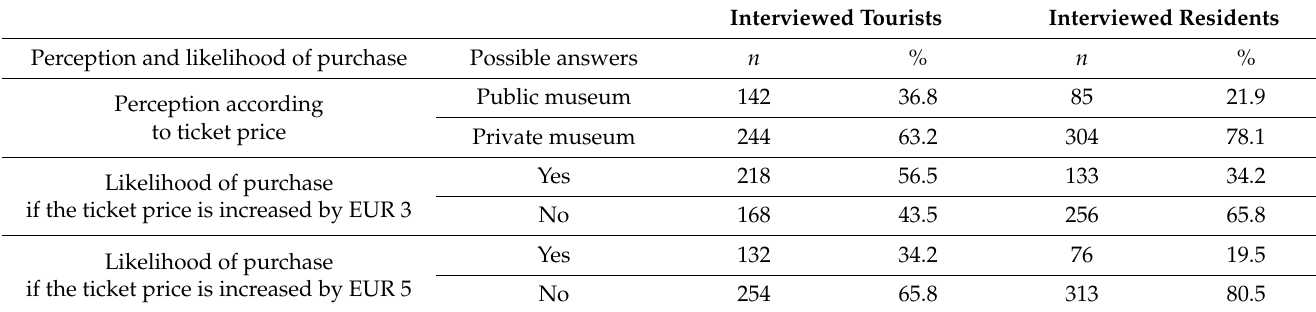
Table 3. Perception according to the ticket price and likelihood of purchase: interviewed tourists and interviewed residents. Interviewed Tourists